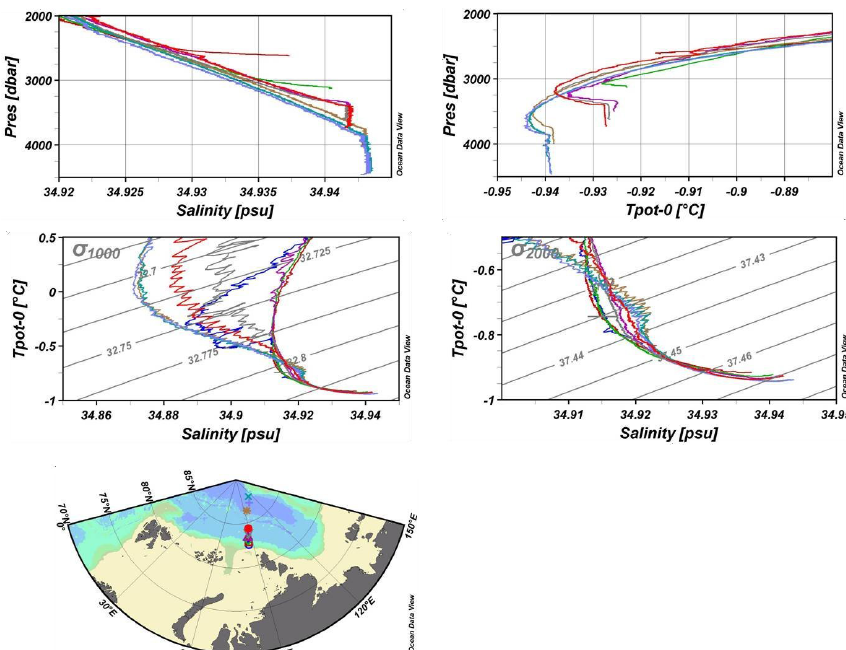
Fig. 18 . Profiles of salinity and potential temperature and θS curves showing the deep and bottom water in the Nansen and Amundsen basins along SPACE section 3. A deep temperature minimum and a homogenous bottom layer are present in both basins. The Amundsen Basin is deeper and its bottom water colder and more saline. In the θS curves the less dense salinity minimum, found both at the slope (blue station) and in the interior, is derived from the Barents Sea inflow. The deep salinity maximum is observed in the Amundsen Basin and indicates an inflow of Amerasian Basin deep water across the Lomonosov